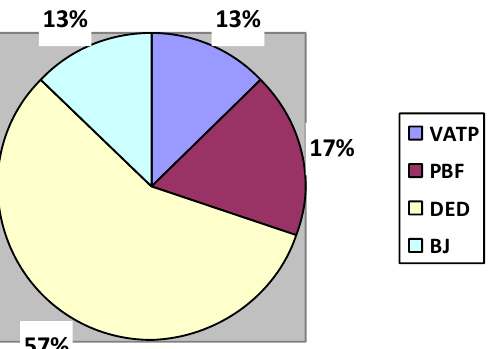
Figure 6. Percentage contribution of AM methods in the medical industry.